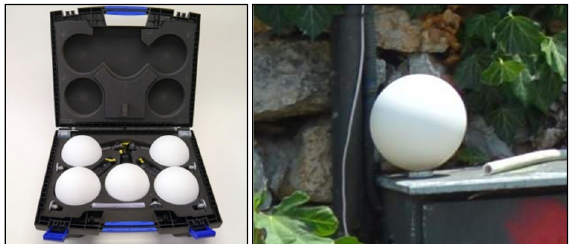
Figure 9. Reference spheres (images taken by the author).